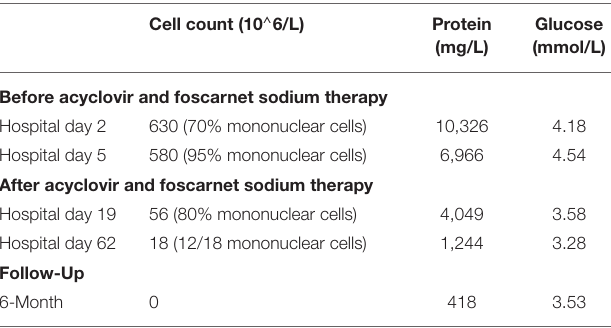
Glucose (mg/L) (mmol/L)